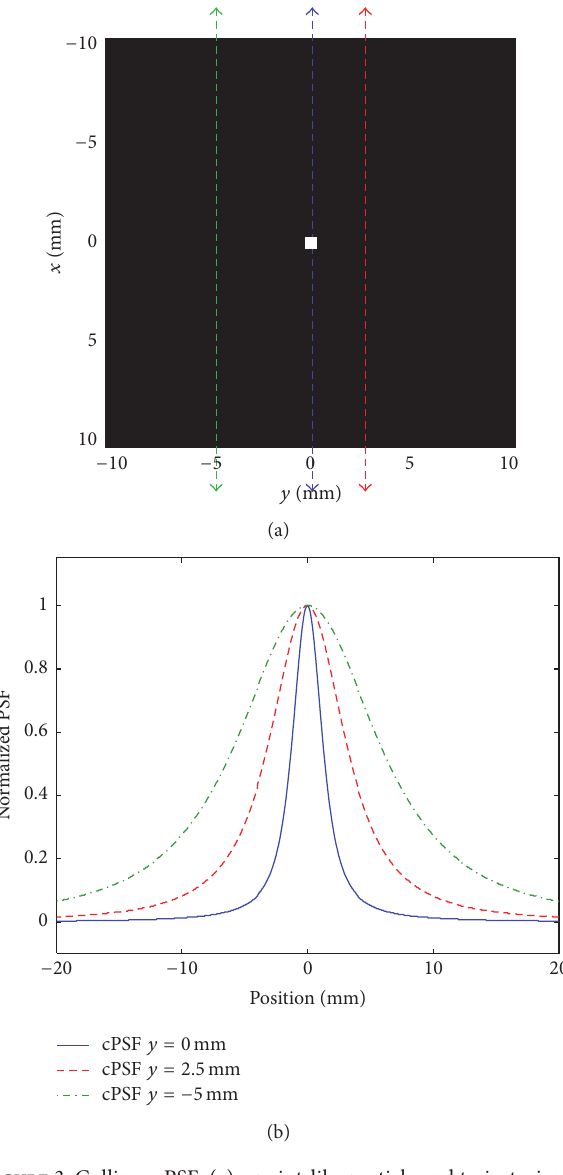
Figure 3: Collinear PSF: (a) a point-like particle and trajectories of the FFP; (b) collinear PSFs at different